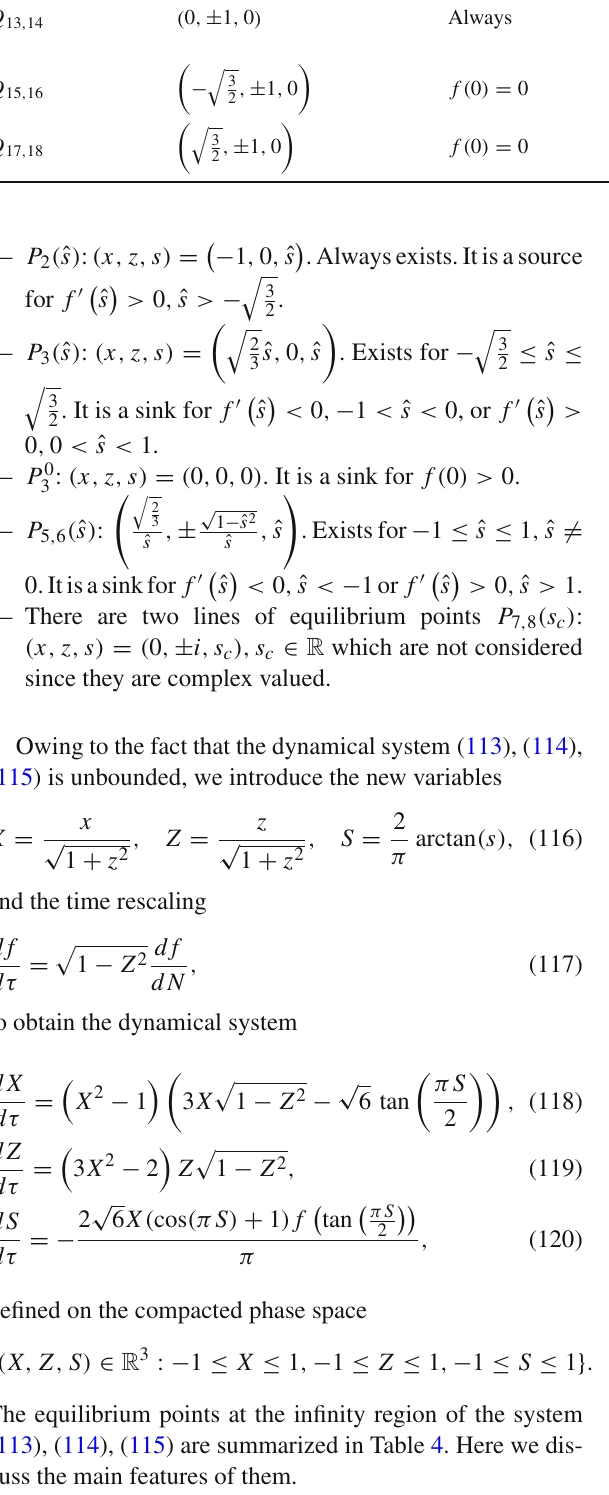
Figure 4b–d illustrates when Q 11 , 12 : ( X , Z ) = ( 1 , ± 1 ) are sinks for s >